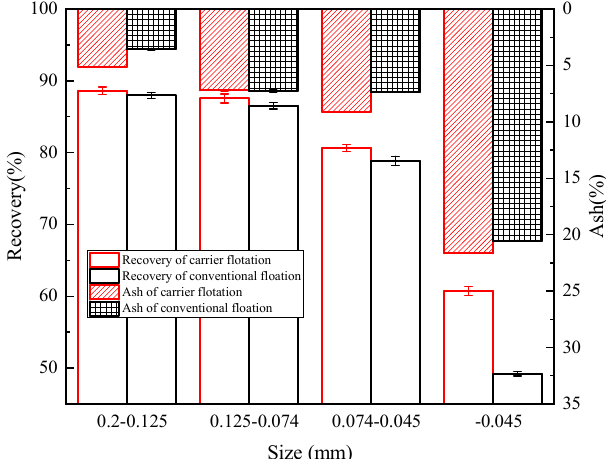
Figure 5. Flotation performance of coal in different size fractions with and without adding polystyrene particles.